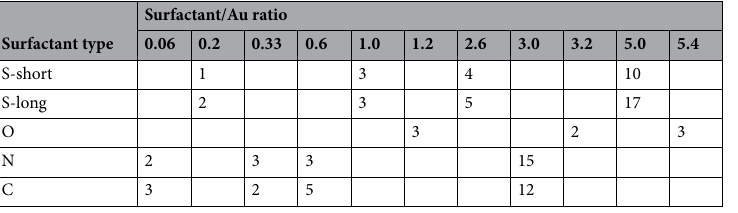
Table 1. Conditions generating the Au NP synthesis processes studied in this work at 343 K by varyingthe type of surfactants, and surfactant/Au ratio. S-short type is referred to mercaptopropionic acid (MPA) and S-long type to 11-mercaptoundecanoic acid